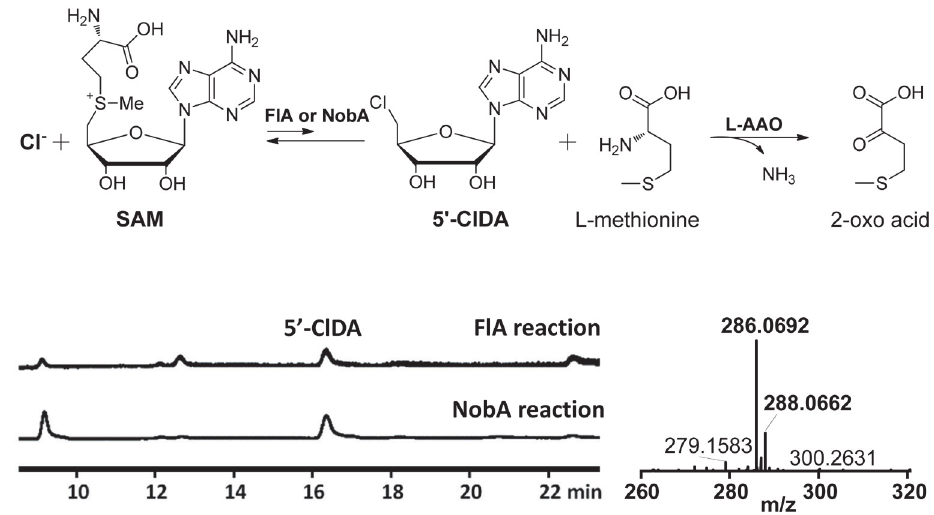
Figure 4. Fluorinase catalyzed conversion of chloride and SAM to 5 ′ -ClDA and l -methionine in the presence of L-amino acid oxidase. The production of 5 ′ -ClDA was determined by HPLC and HRMS. The observed values (m/z [M+H] + 35 Cl = 286.0692, 37 Cl = 288.0662) are consistent with the calculated values (m/z [M+H] + 35 Cl = 286.0707, 37 Cl =